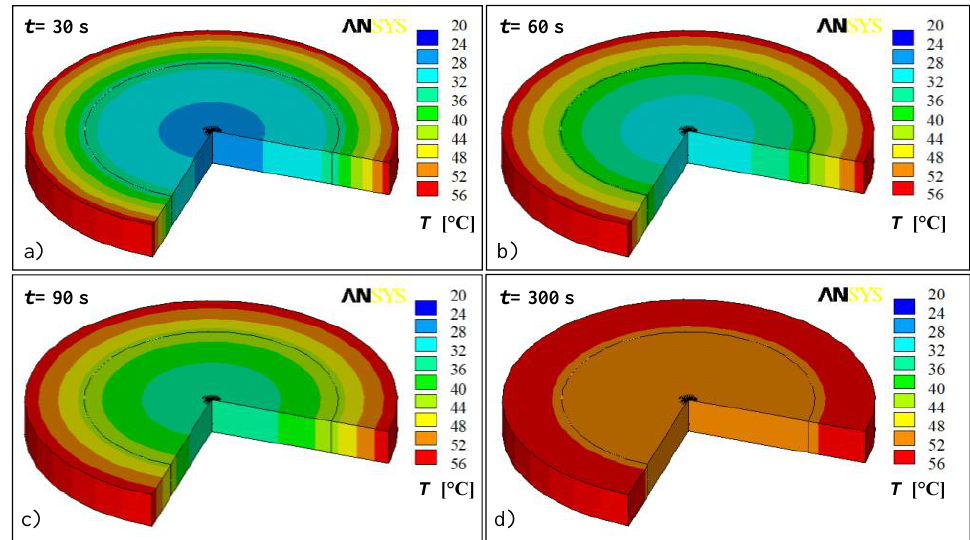
Figure 9. Temperature distribution in the probe 1 in the time of ( a ) 30 s, ( b ) 60 s, ( c ) 90 s, and ( d ) 300 s after immersing the probe in a water bath at approximately 55 °C.